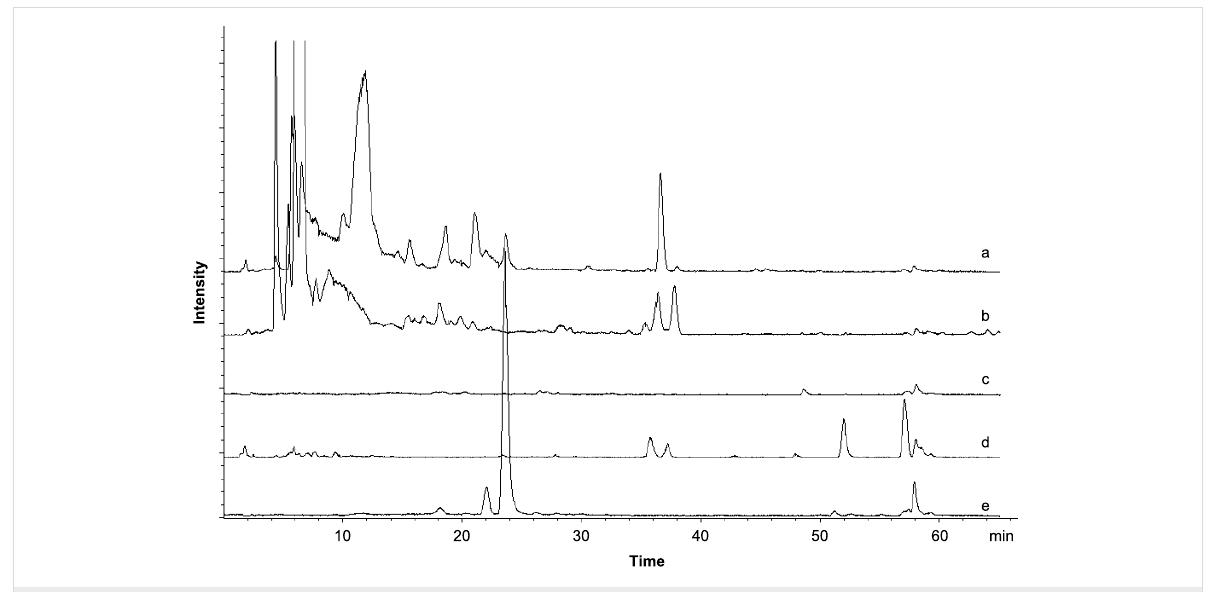
Figure 4: Extracted ion chromatograms for sacrolide A ( 1 ) molecular ion at m/z 307 [M – H] − in the LC–MS analysis of aqueous 90% MeOH fractions from the ethanolic extracts of (a) raw alga, (b) dry product, (c) brined product, and (d) raw alga boiled in 3% NaHCO 3 for 1 min. Chromatogram (e) shows the elution of purified sacrolide A ( 1 ) at t R 23.6 min.